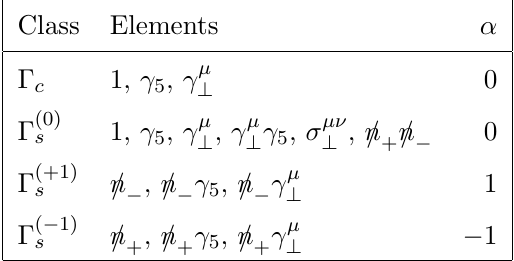
Table 4. Dirac matrices and their scaling (cid:11) n under \boost" or type-III RPI transformations. A O